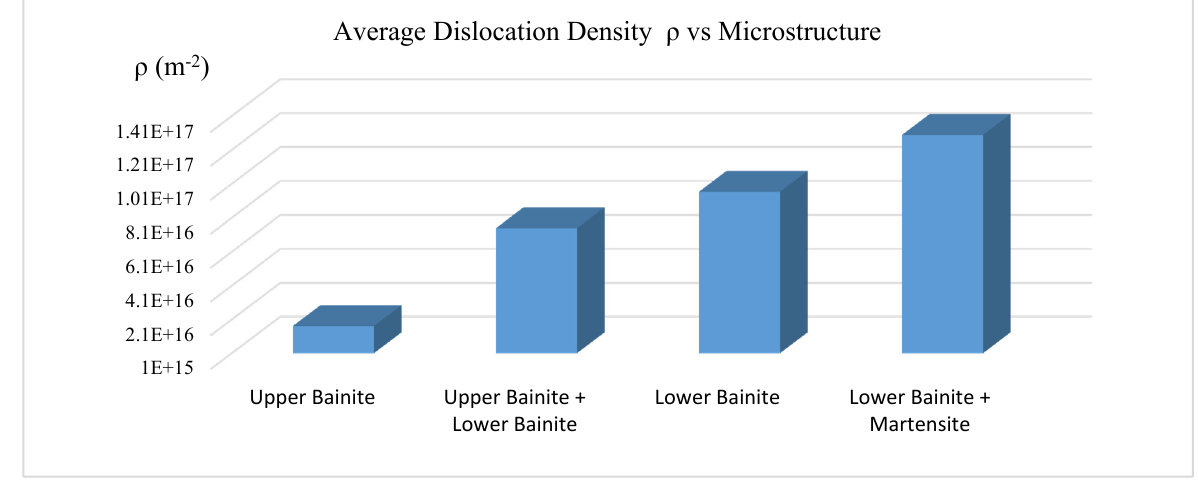
Figure 5. Dislocation density vs. microstructure.